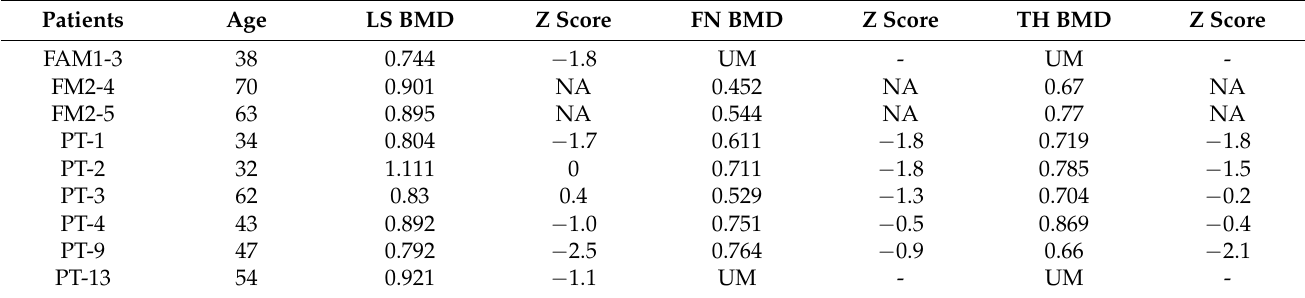
Table 4. Results of bone mineral density in nine individuals.